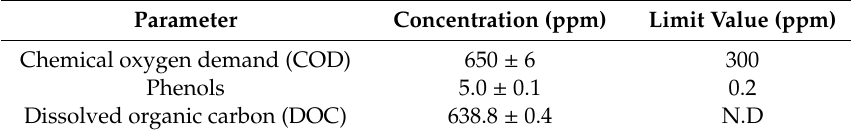
Table 1. Raw wastewater characterization parameters and limit values for